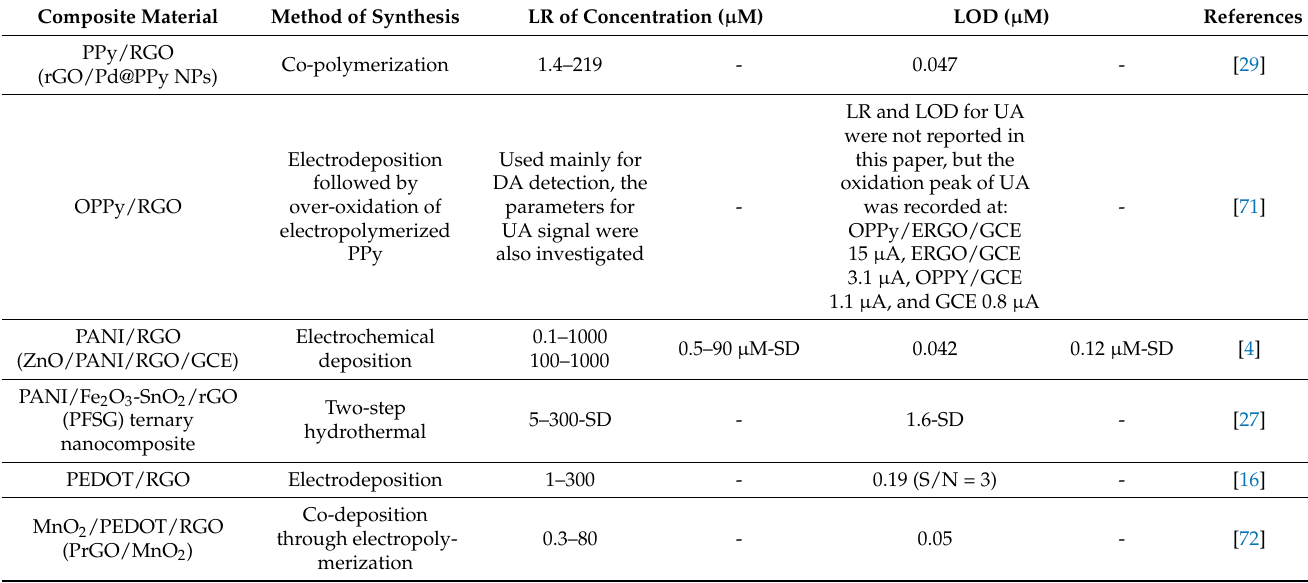
Table 3. Composite materials used as sensors for the detection of UA and their